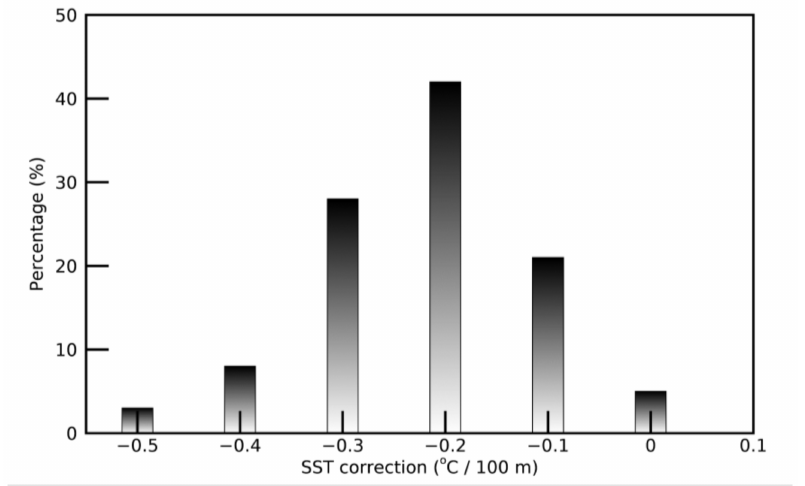
Figure 3. Percentage of the correction rate with the flight altitude according to Merlin